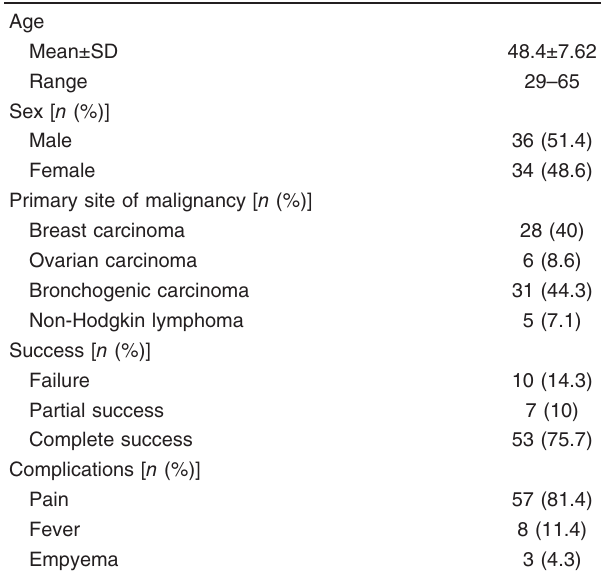
Table 1 Demographic, clinical, outcome data in studied cases and procedure